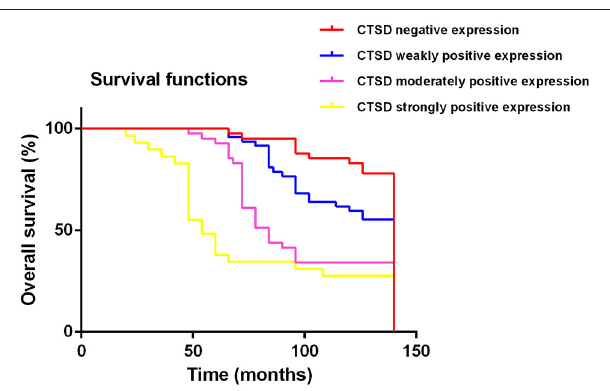
FIGURE 2 | Kaplan-Meier survival analysis on CTSD negative expression, CTSD weakly positive expression, CTSD moderately positive expression, CTSD strongly positive expression group in the patients with SACC (log-rank test, p <